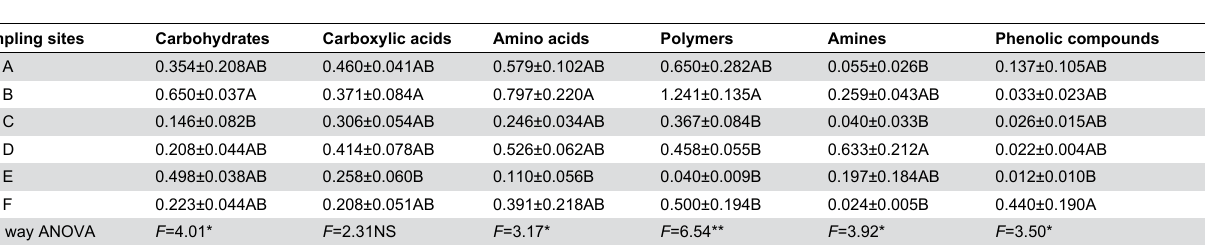
Table 4. Variance analysis of utilization of the six groups of carbon sources (carbohydrates, carboxylic acids, amino acids, polymers, amines and phenolic compounds) located in BIOLOG ECO plate by sediment bacterial community from each six sampling sites (site A, site B, site C, site D, site E, site F ) in the Zhou cun drinking water reservoir, eastern China.